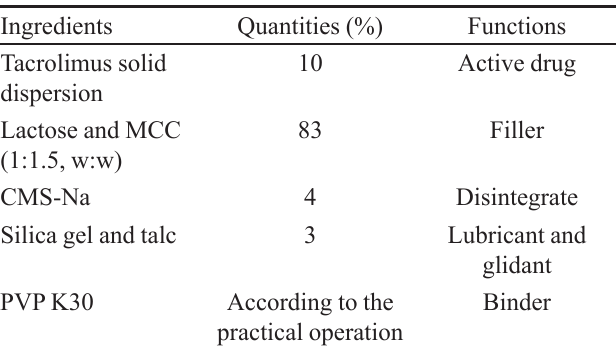
TABLE III - Composition of optimized tacrolimus-SDP Ingredients